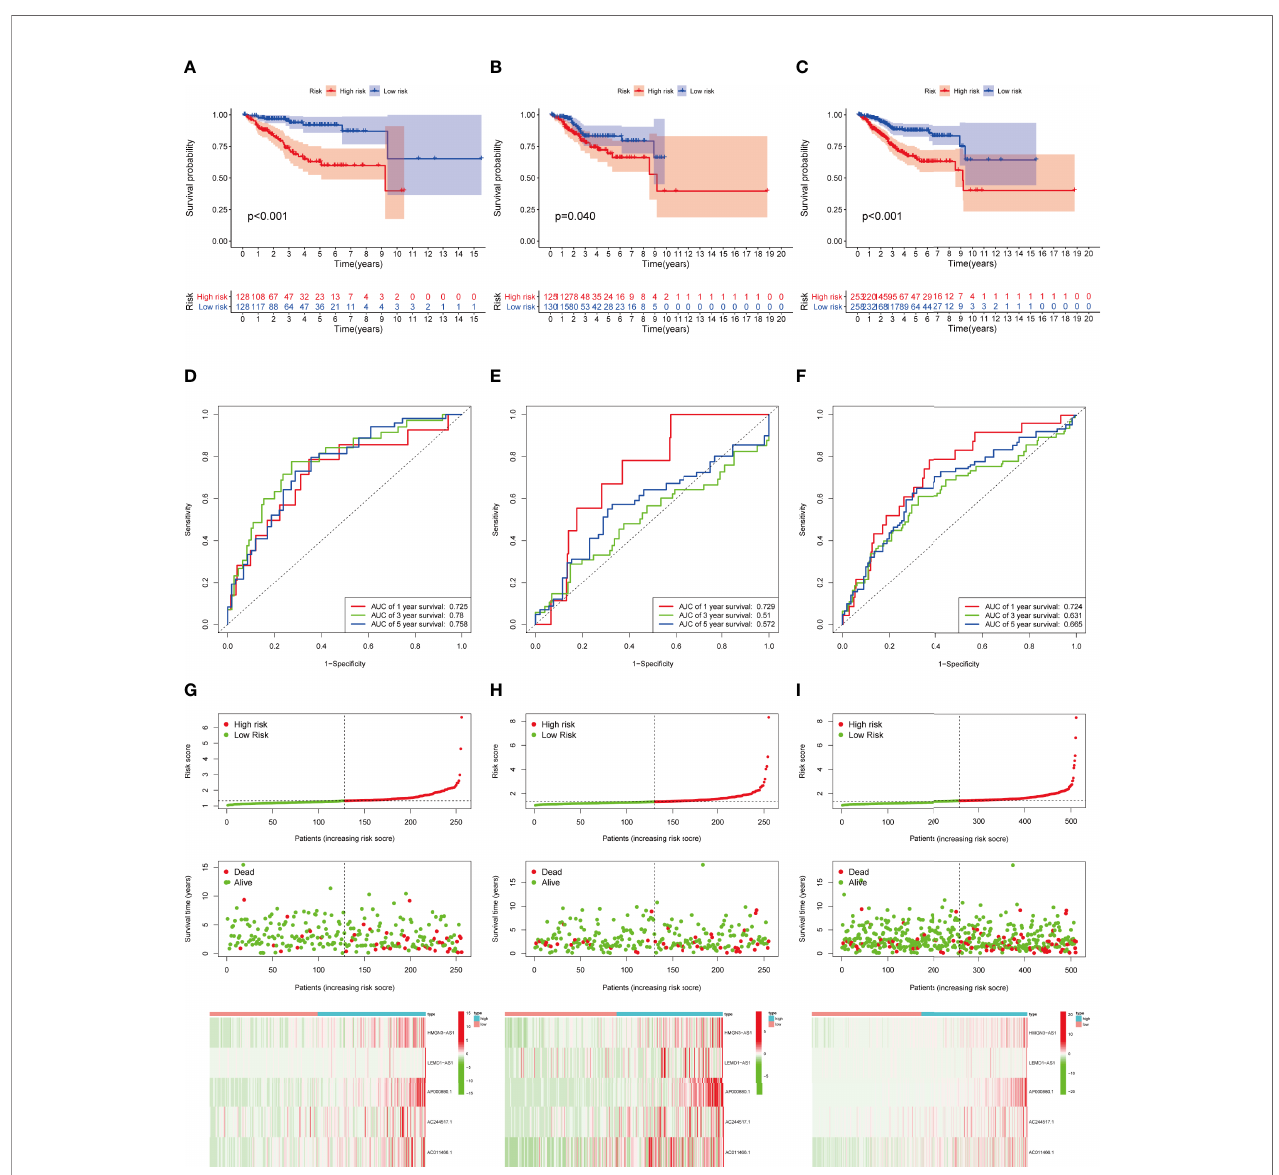
FIGURE 4 | Construction and validation of IRLPS. (A-C) Survival analysis for patients in the (A) training, (B) testing, and (C) entire cohort. (D-F) ROC curves measuring the predictability of the signature in the (D) training set, (E) testing set, and (F) entire cohort. (G-I) Distribution of risk score, survival status, and heatmap of the transcription levels of fi ve prognostic signatures in the (G) training set, (H) testing set, and (I) entire